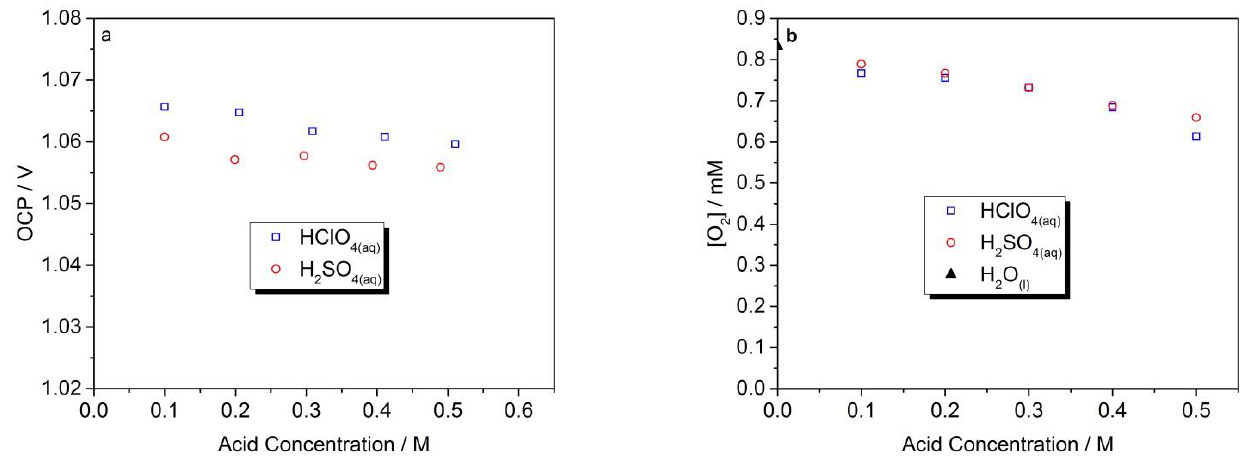
Figure 4. ( a ) The measured OCP of a Pt/C (JM) GDE with different acid concentrations. ( b ) The measured [O 2 ] in the electrolytes through use of a Clark cell.